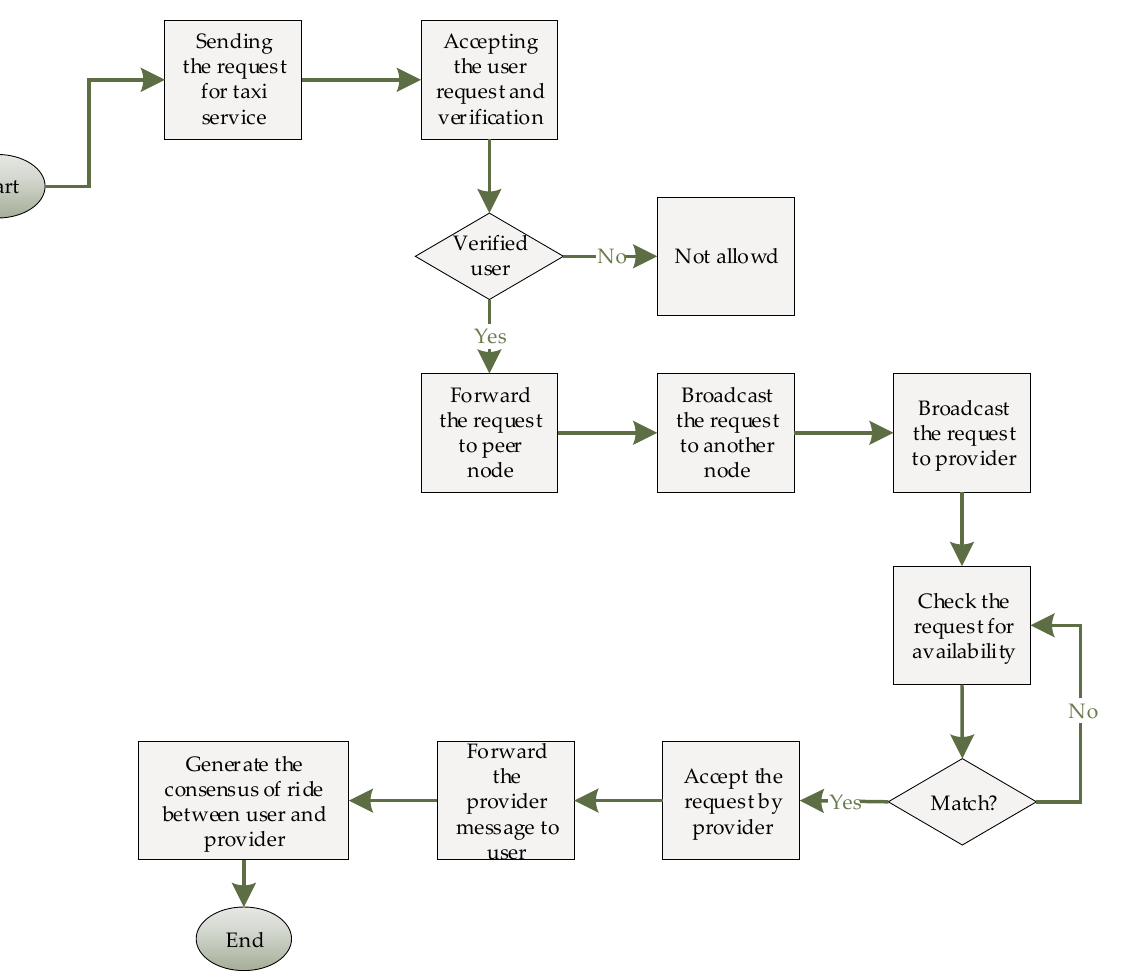
Figure 8. Workflow of the taxi demand blockchain